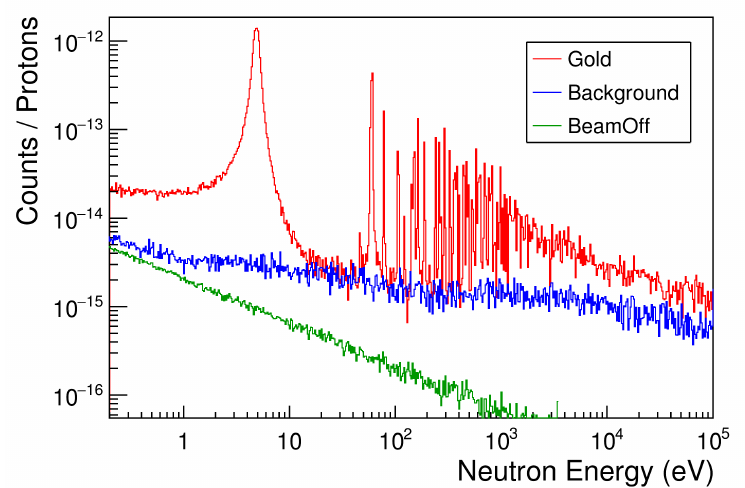
Figure 3. Energy spectrum measured with the gold sample (red), compared with the total evaluated background (blue) and the ambient background (green).